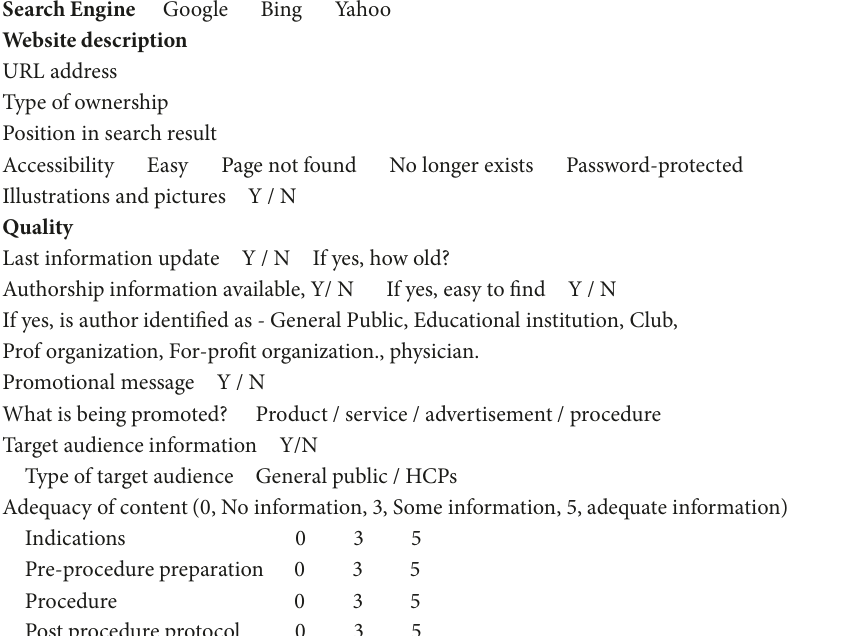
Table 1: Assessment tool for the website quality